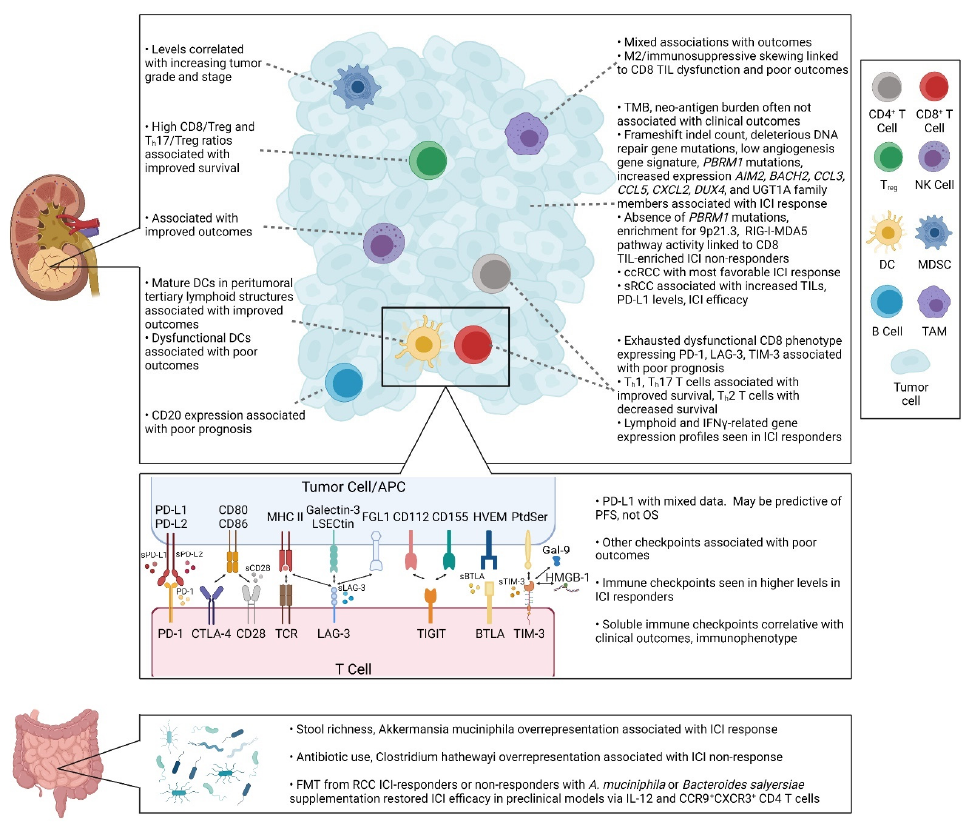
Figure 2. Biomarkers for immunotherapy in RCC. Text highlighting key biomarker-related data regarding immune cells, tumor cells, immune checkpoint molecules, and the microbiome.